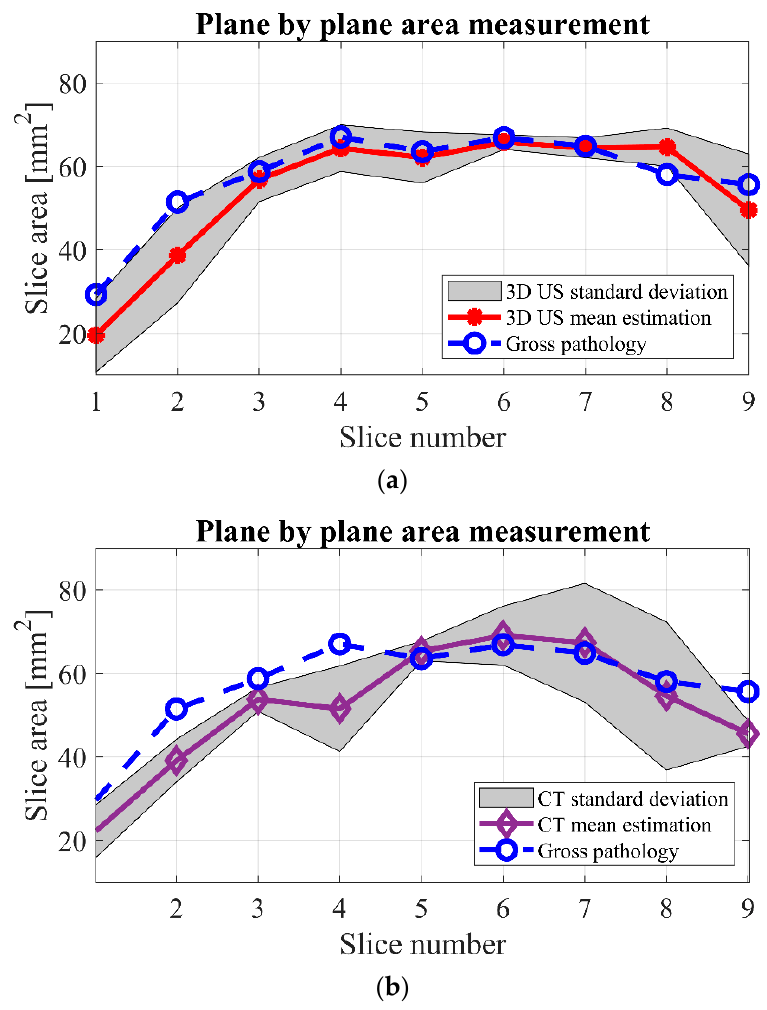
Figure 4. Area measurement at parallel equally distanced planes corresponding to the pathological slices. The dashed blue line is the result of the pathological assessment, and the shaded gray area is the standard deviation of the three measurements. ( a ) 3D ultrasound results compared to the pathological assessment. The solid red line is the mean area at each slice obtained by 3D ultrasound. ( b ) CT results compared to the pathological assessment. The solid purple line is the mean area at each slice measured by CT. Table 1. Mean area ( A_mean ± S ) in mm 2 measured on each slice by CT, 3D ultrasound, and gross pathology. The mean results are calculated by averaging over three different delineation sessions.